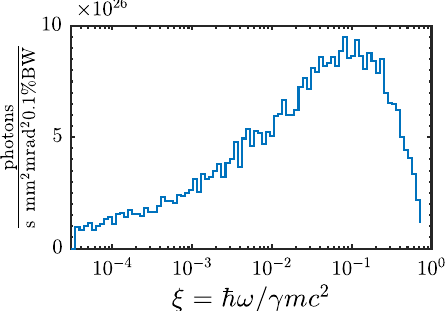
FIG. 4. Brilliance of the beamstrahlung γ rays source, for two colliding beams of N ¼ 5 . 8 × 10 10 particles, E ¼ 30 GeV en- 3 μ m ergy, σ 0 ¼ 1 μ m spot size and σ z ¼